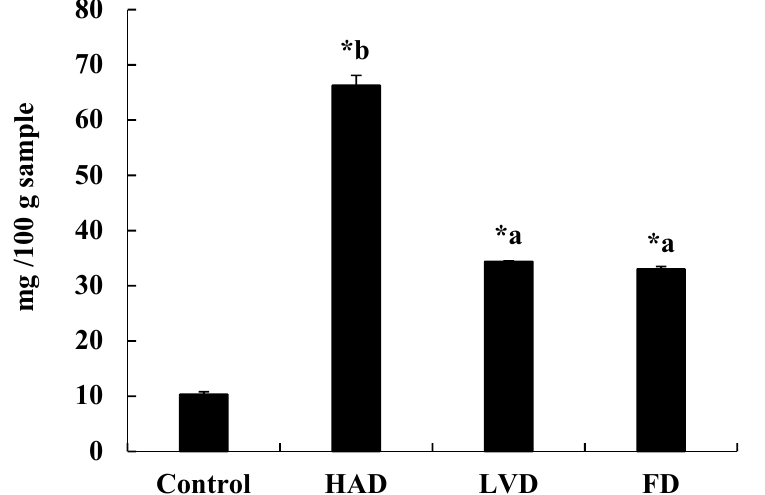
Figure 1. Analysis of volatile basic nitrogen (VBN) in the yellow croakers by various drying methods. Values are mean ± SE. The values are significantly different between groups according to Student’s t - test: * p < 0.05, Control vs. other groups (HAD, LVD, FD), respectively. The values not sharing a common letter ( a and b ) are significantly different among groups using one-way ANOVA followed by Duncan’s multiple-range test at p < 0.05. Control, yellow croakers by cold air drying to remove moisture. HAD, yellow croakers by hot air drying. LVD, yellow croakers by low temperature vacuum drying. FD, yellow croakers by freeze drying. Table 2. Analysis of 18 free amino acids in the yellow croakers by various drying methods (mg / 100 g)